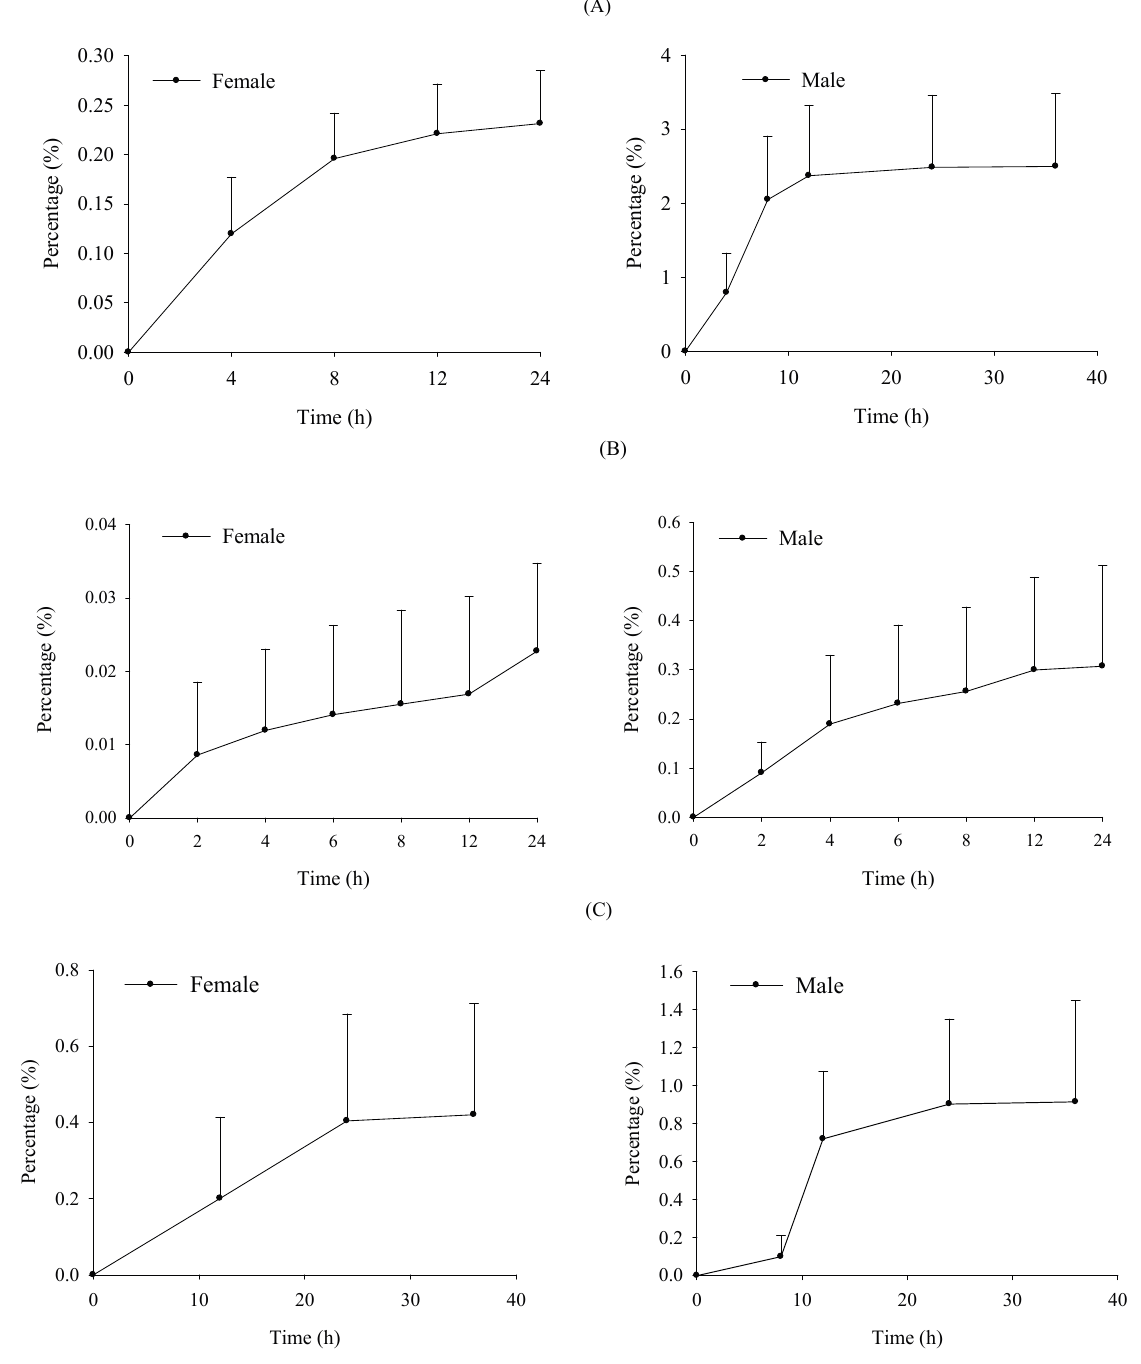
Figure 6. Mean plot of cumulative excretion of verticione following i.g. administration of 2 mg/kg to SD rats. ( A ) urine; ( B ) bile; ( C ) feces.